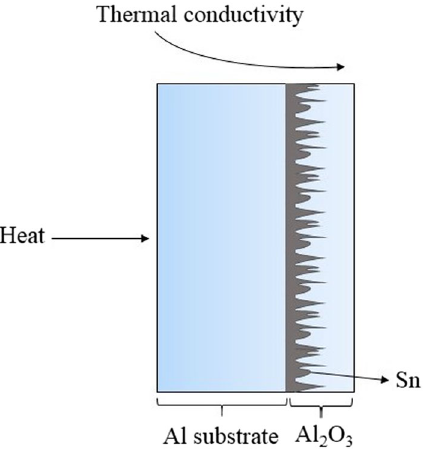
Fig. 7 Heat flow in the thermal conductivity measurement on the Sn– Al 2 O 3